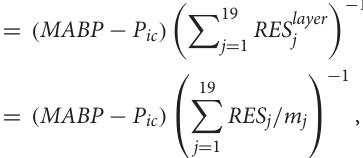
a constant P ic value of 5 mmHg was assigned to all patients. The mean ICP values in preterm neonates can vary from 2.7 mmHg (31, 32) to 12.5 mmHg (33) depending on the measurement method. However, according to (32), ICP values greater than 7 mmHg are “indicative of intracranial hypertension, but occurred head.” The used ICP value of 5 mmHg is a mean between 3 and